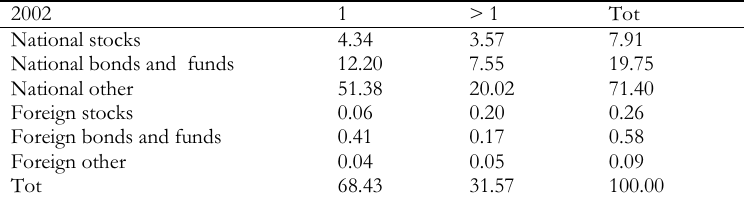
Italian households financial wealth by number of banks used, 2002 , percentages.